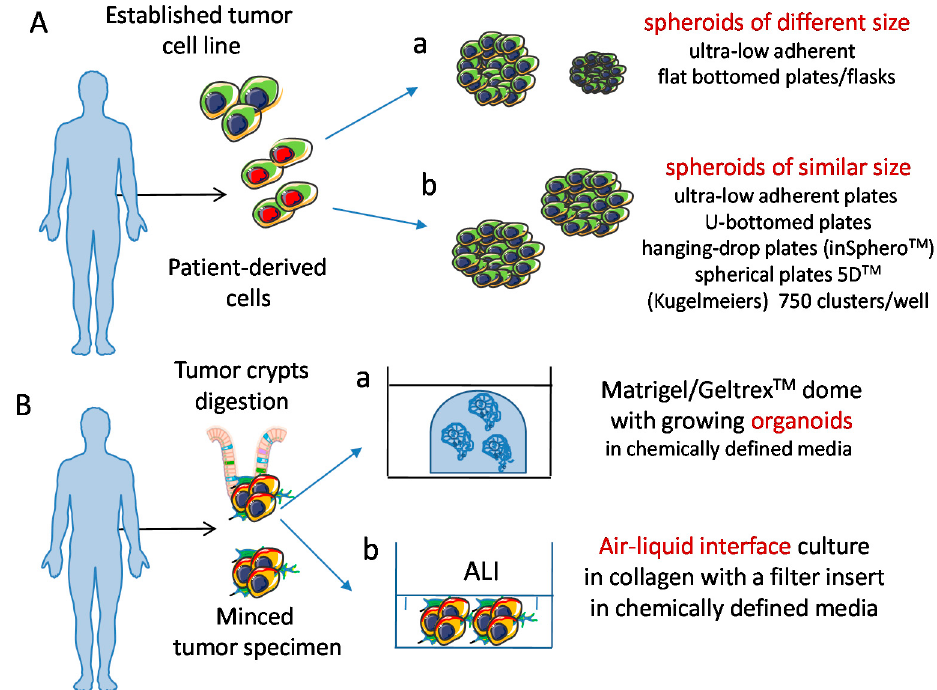
Figure 3. Schematic representation of 3D culture models of tumor cells. ( A ) Spheroids can be obtained from tumor cell lines and tumor cell suspensions. Physical features of spheroids can change, depending on the culture conditions used, resulting in different (a) or similar (b) size. ( B ) Organoids can be derived from tumor cell suspensions seeded either in matrigel/geltrex domes (a) or in air liquid interface (ALI) cultures, (b) and can display a well-defined polarization of molecules like those localized at the basal or apical pole of cells. Importantly, spheroids and organoids can be cultured in chemically defined media; this is of relevance to avoid any influence during the experimental procedures of animal/viral derived factors; this leads to the generation of a more physiologic